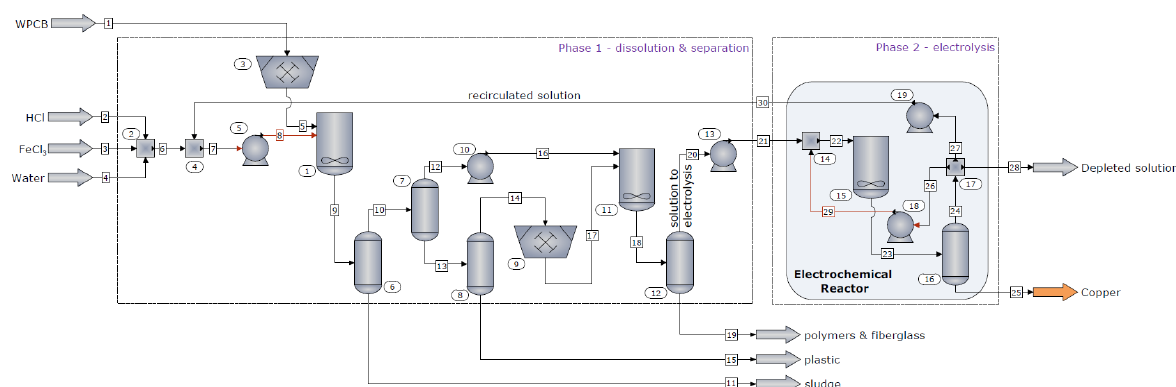
Figure 3. Recycling plant process flow diagram.